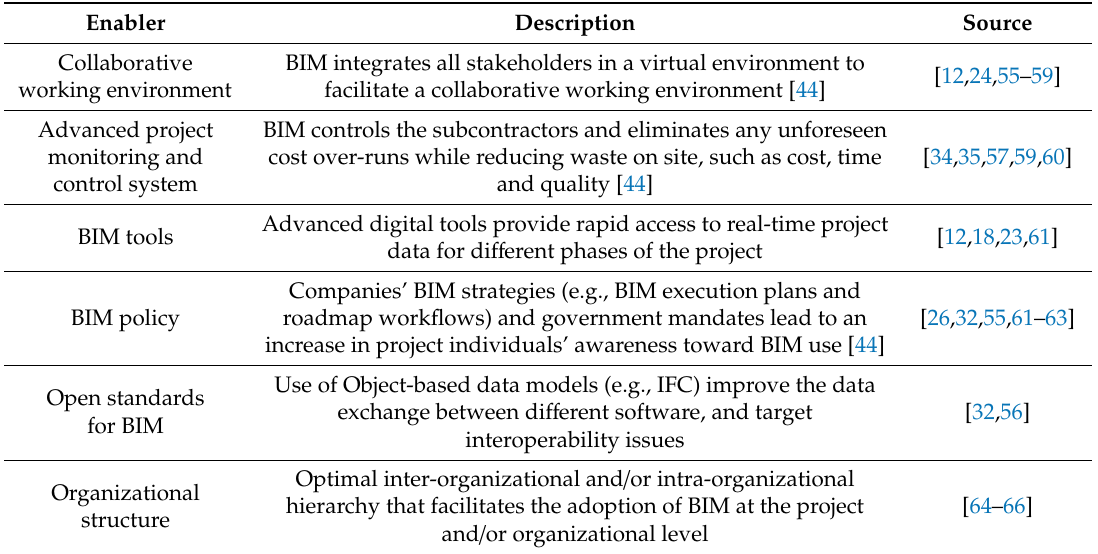
Table 6. Enablers of the BIM